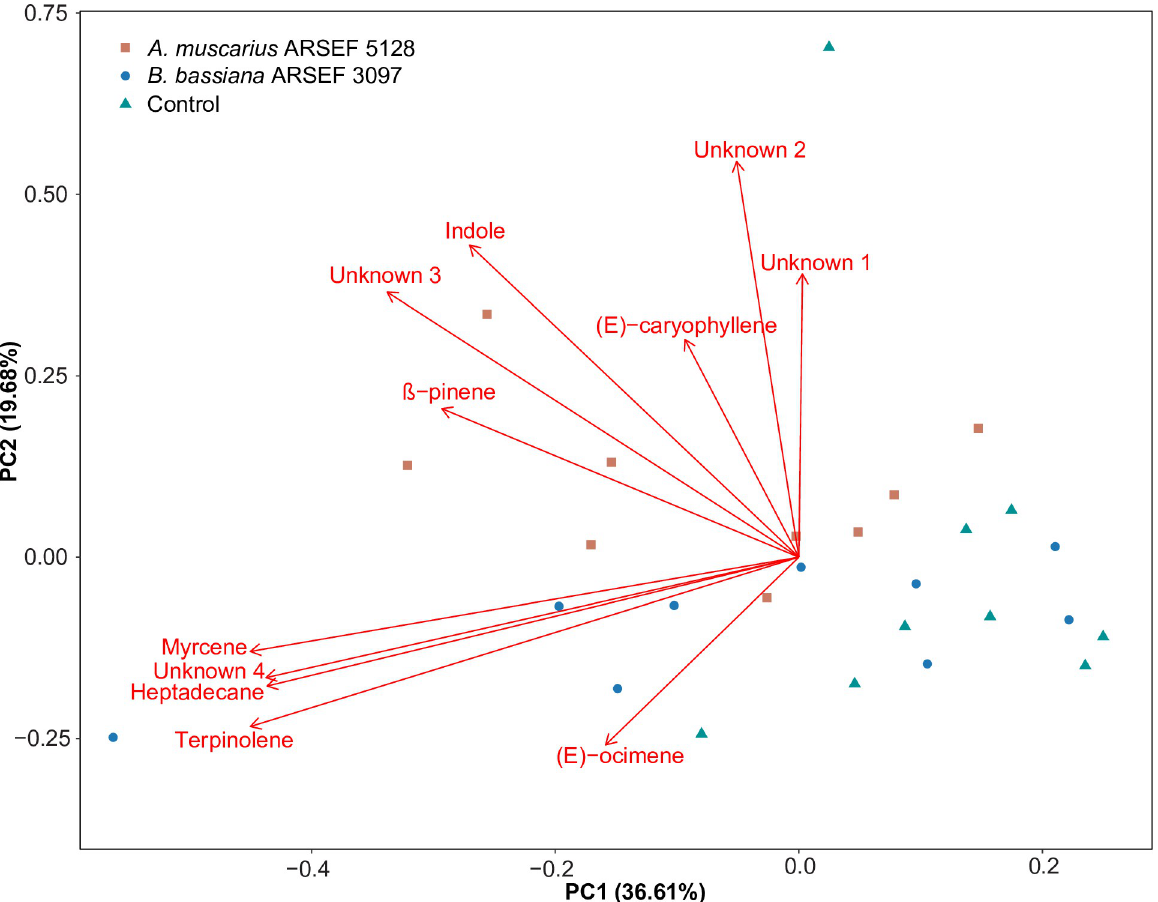
Fig 3. Principal component analysis (PCA) of plant volatiles emitted by sweet pepper plants inoculated with Akanthomyces muscarius ARSEF 5128 (orange) or Beauveria bassiana ARSEF 3097 (blue) or non-inoculated plants (green) ( n = 9). Volatiles were collected by dynamic headspace sampling for 48 h and identified by GC-FID/GC-MS. The plot visualizes the location of each analyzed sample on each PC with the percentage of explained variation in parentheses, whereas vectors (in red) visualize the loadings for each variable. Volatile composition differed significantly among treatments ( F = 2.21, P = 0.035;